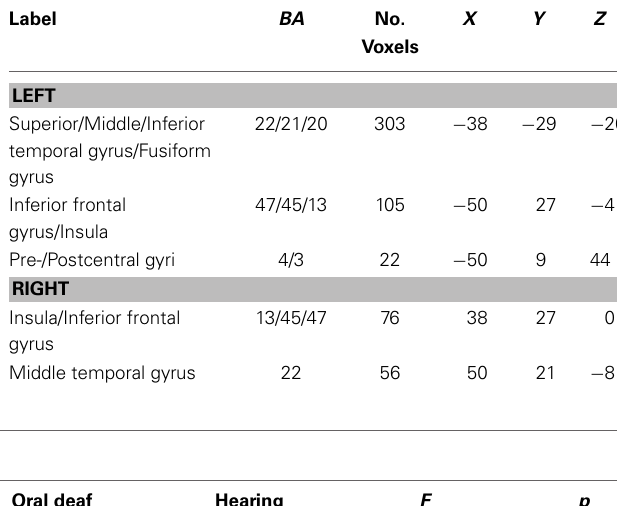
Table 3 | Reading network common to all three groups as determined by conjunction analysis.